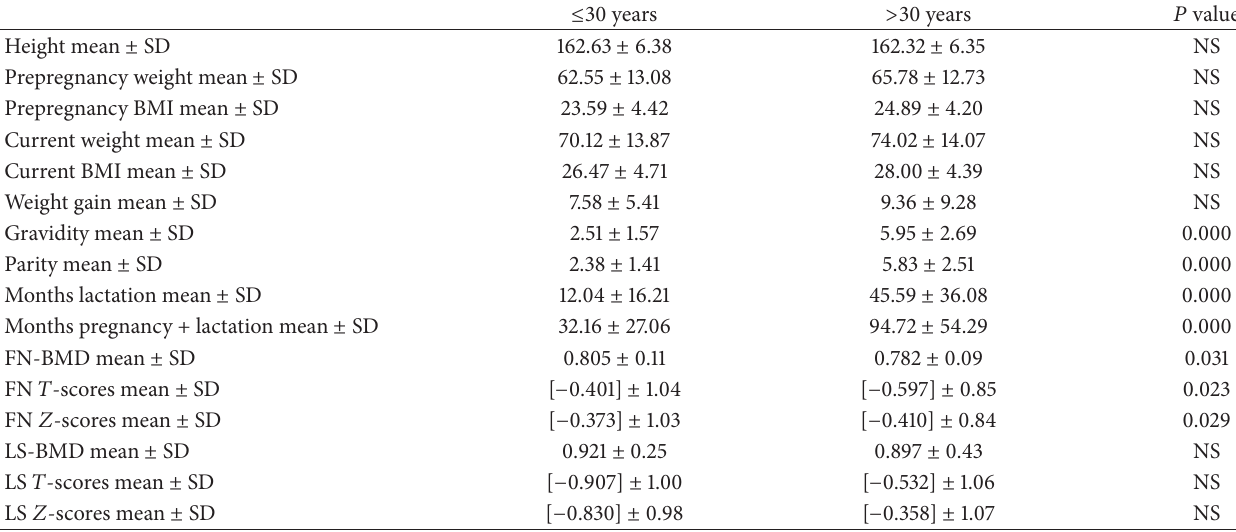
Table 2: Comparison of means ± SD of demographic characteristics in women ≤ 30 years ( 𝑛 = 73) and women > 30 years of age ( 𝑛 = 59); significance based on Levene’s test for Equality of Variances.